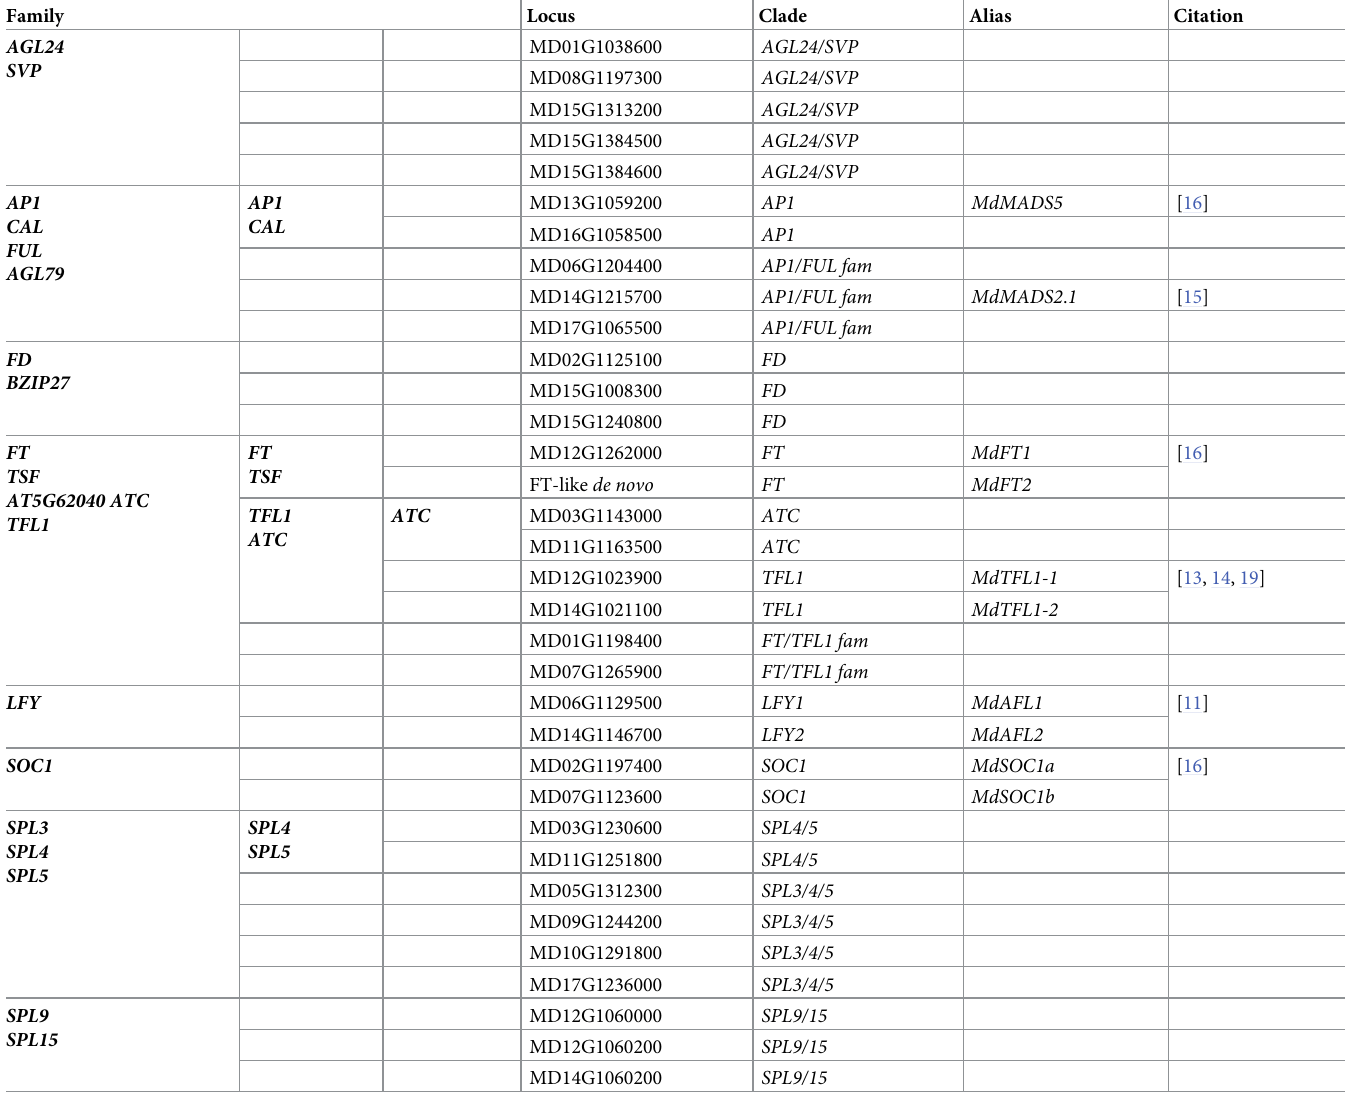
Table 2. Identified homologs of Arabidopsis flowering genes in apple.